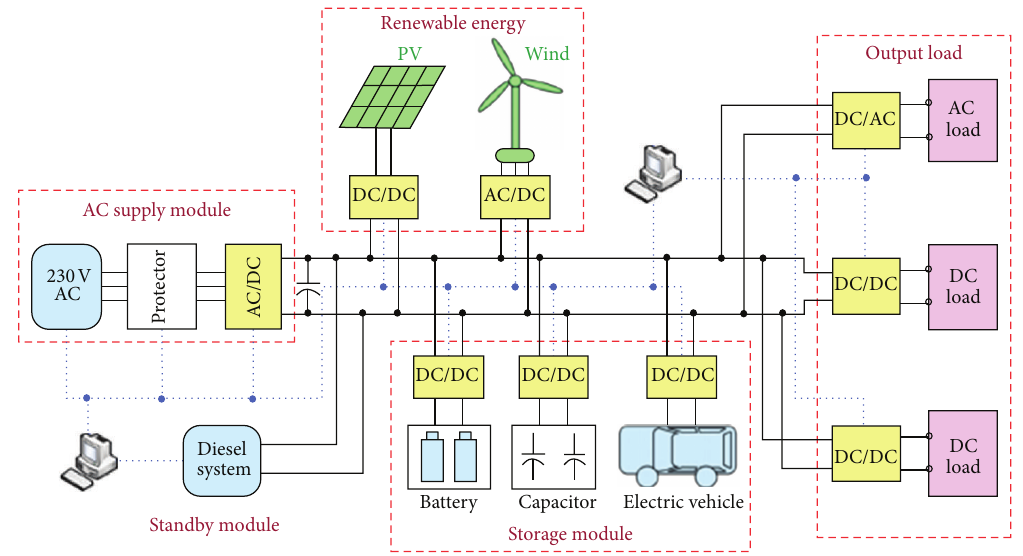
Figure 4: DC microgrid system